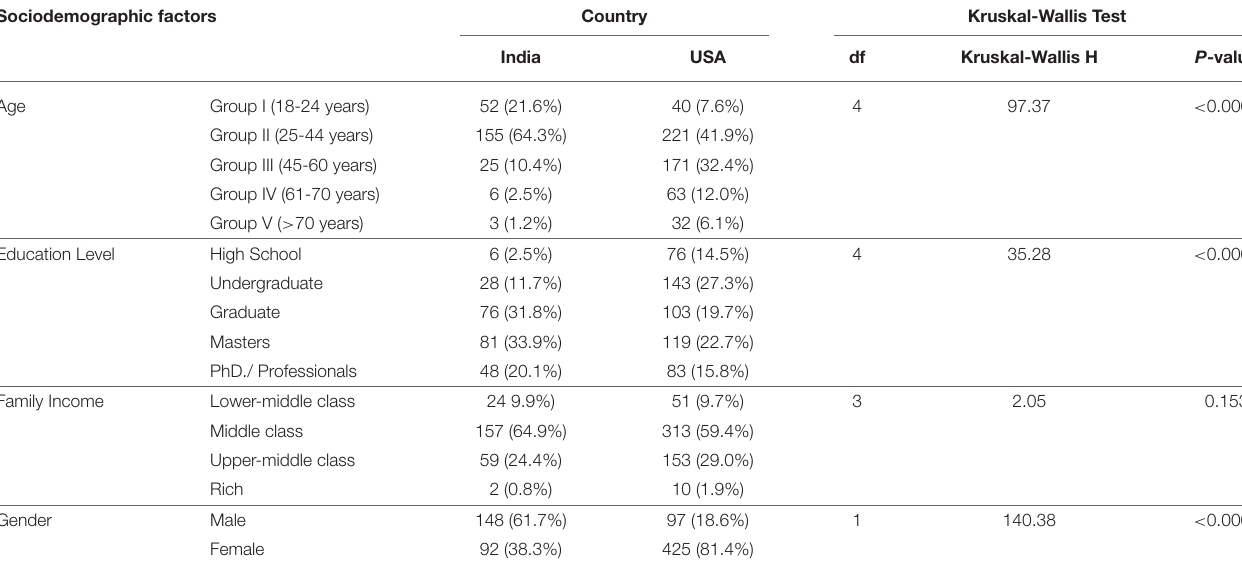
TABLE 1 | The distribution of sociodemographic factors and comparison between Indian and US-based participants using Kruskal-Wallis Test. Sociodemographic factors